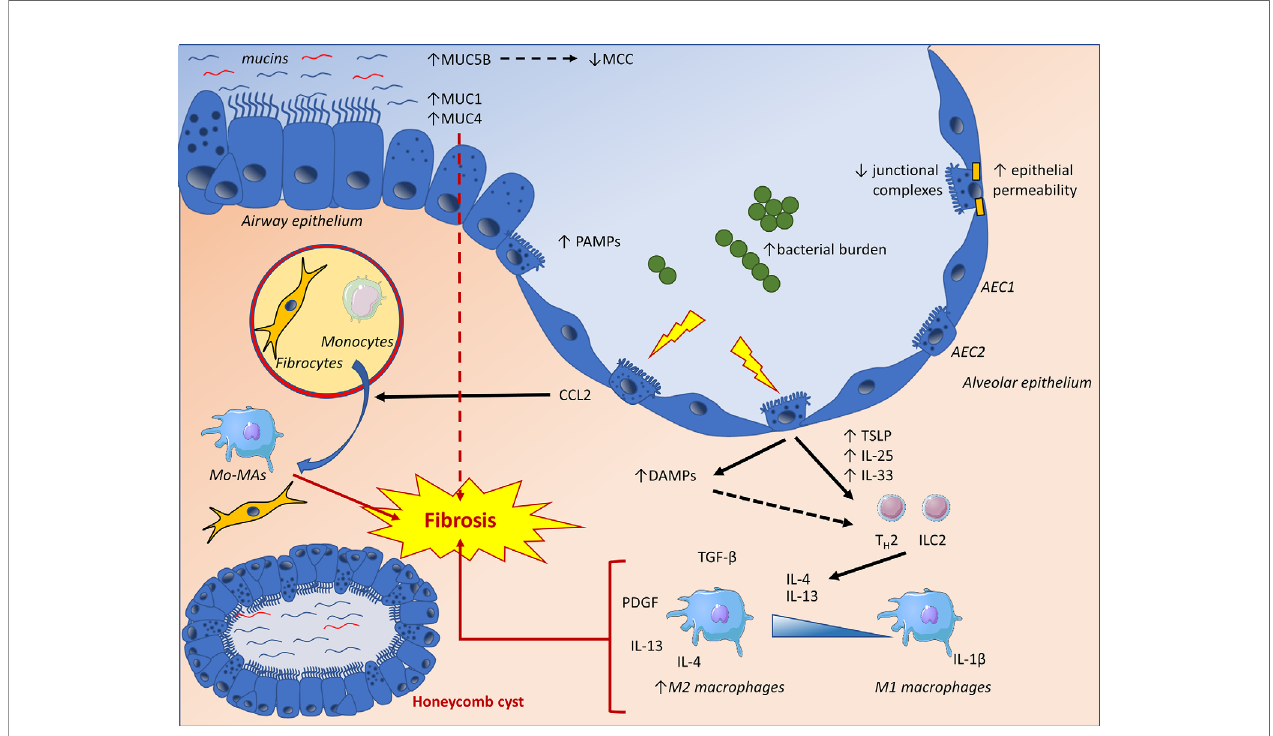
FIGURE 2 | The IPF lung epithelium displays increased concentrations of secreted and membrane-bound mucins, as well as altered junctional complexes, potentially in fl uencing local barrier mechanisms and fi brosis through impaired mucociliary clearance (MCC), promotion of epithelial to mesenchymal transition (EMT) and increased epithelial permeability. Lung epithelial cells are also confronted to an increased bacterial burden and pathogen-associated molecular patterns (PAMPs). Furthermore, epithelial damage will result in the production of damage-associated molecular patterns (DAMPs), triggering pro-in fl ammatory pathways and T H 2 polarizing cytokines. These cytokines exert a pro- fi brotic in fl uence by directly affecting mesenchymal cells and polarizing macrophages towards an alternatively activated phenotype (M2). Finally, epithelial dysfunction will result in the release of CCL2, a chemokine directly affecting fi broblasts as well as fi brocyte recruitment and differentiation while mediating the recruitment of monocytes to the site of injury. The latter will differentiate into monocyte-derived macrophages (Mo-MA), which have been implicated in lung fi brosis. AEC1, alveolar type-1 epithelial cell; AEC2, alveolar type-2 epithelial cell; Mo-MA, monocyte-derived macrophage; MCC,